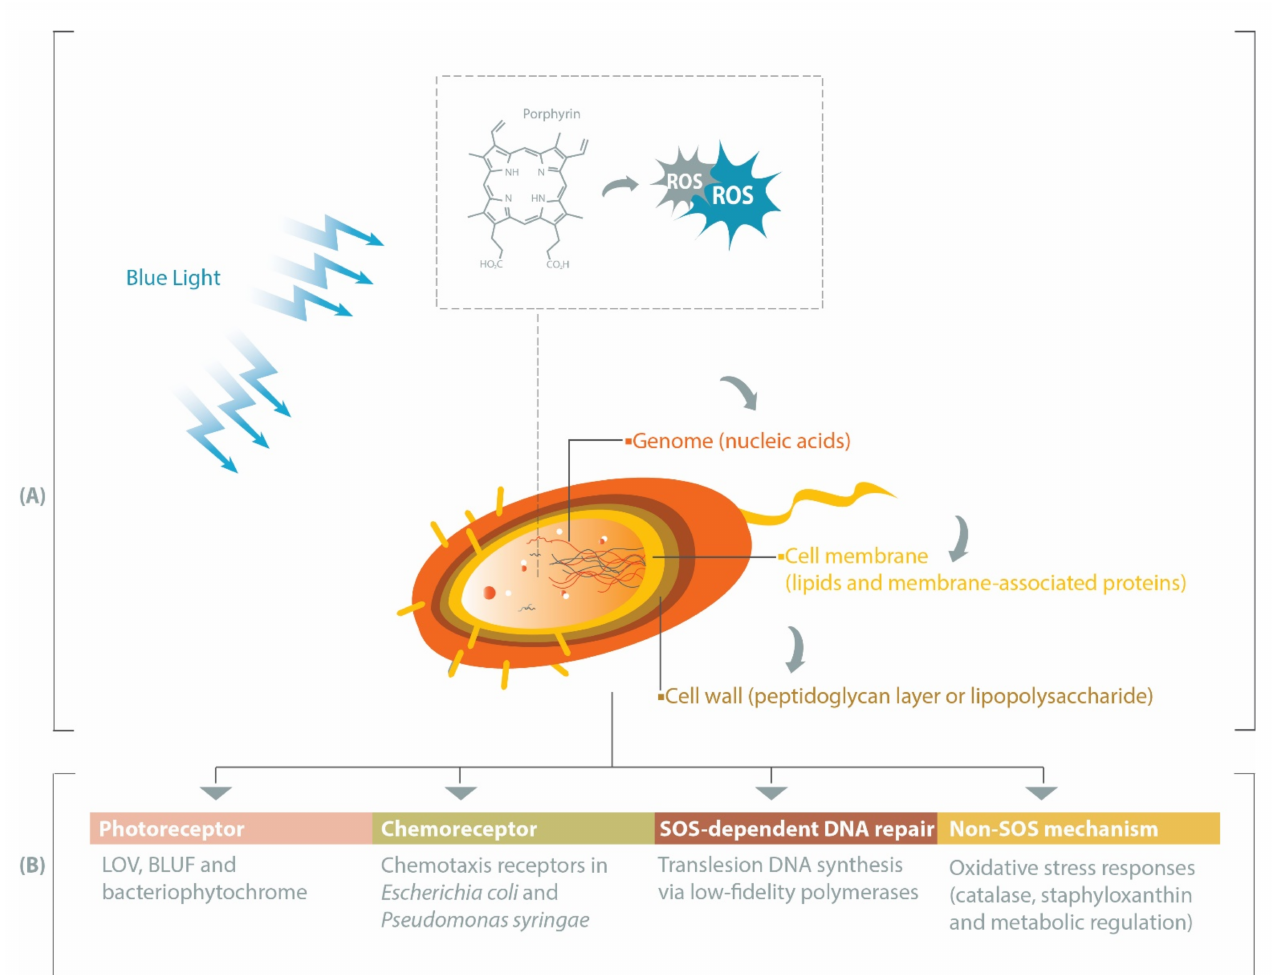
Figure 1. Pathways involved during blue light-mediated antimicrobial treatment. ( A ) Widely accepted inactivation mechanism of antimicrobial blue light, in which endogenous porphyrins are activated to form reactive oxygen species (ROS) that subsequently inflict oxidative stress upon different parts of the bacterial cell. ( B ) Bacteria can respond to blue light through four other pathways, leading to differential physiological behaviors and survival rates, which are discussed in this